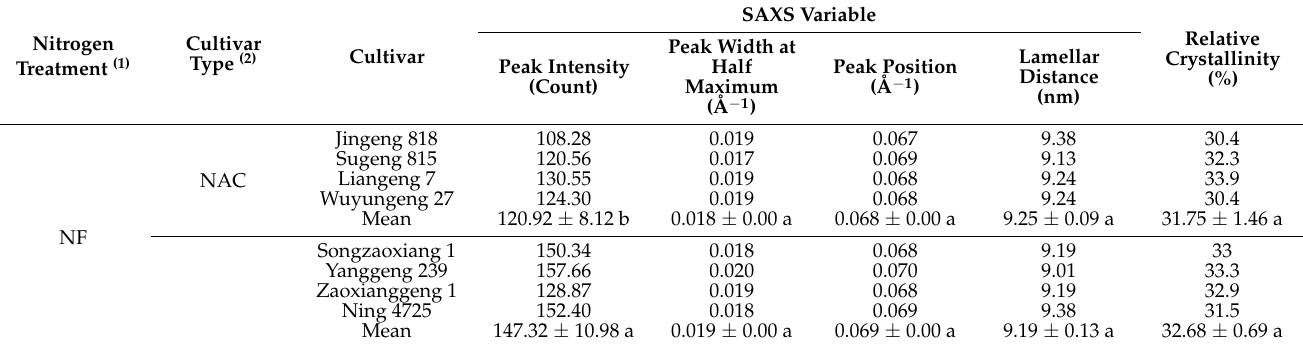
Figure 2. X-ray diffraction patterns of the starch of japonica rice cultivars with different contents of amylose, with or without nitrogen fertilization. ( a ) NAC, with fertilization; ( b ) LAC, with fertilization; ( c ) NAC, without fertilization; ( d ) LAC, without fertilization. Table 9. Small-angle X-ray scattering (SAXS) variables and relative crystallinity of the starch of japonica rice cultivars with different contents of amylose, grown with or without nitrogen fertilizer.